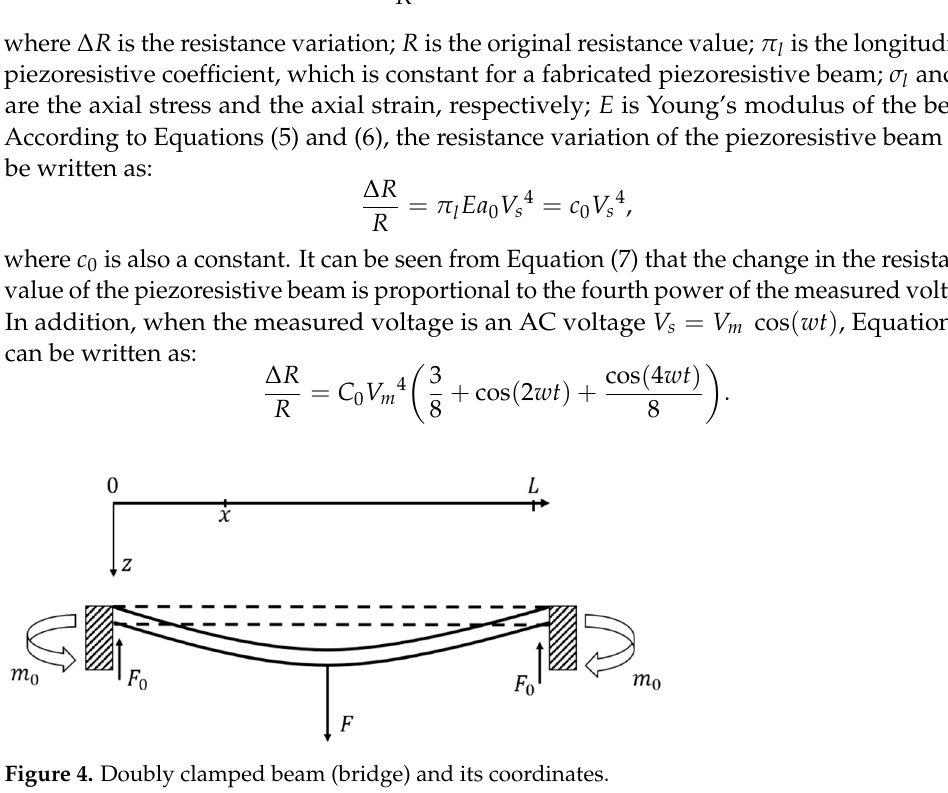
Figure 4. Doubly clamped beam (bridge) and its coordinates.